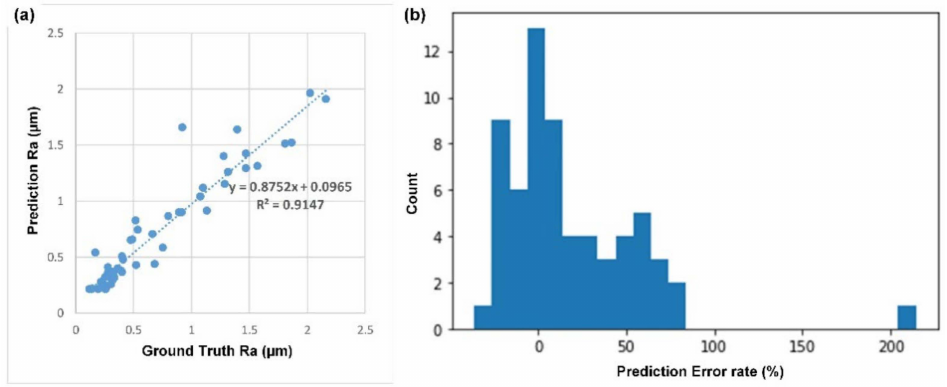
Figure 17. Performance of the second task: Estimation of the surface roughness Ra: ( a ) Scatter diagram of the estimated Ra versus the ground truth and ( b ) histogram of the Ra error